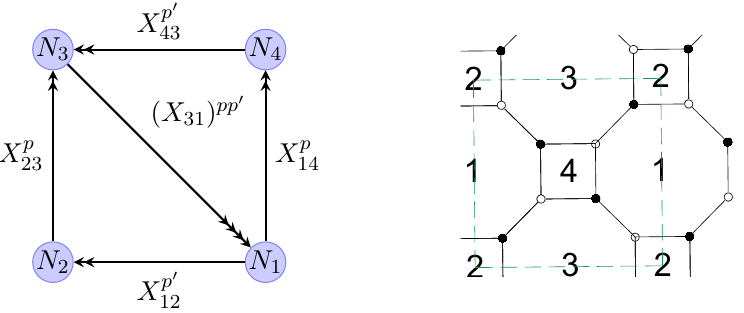
with dualization on node 0. The quiver is 2